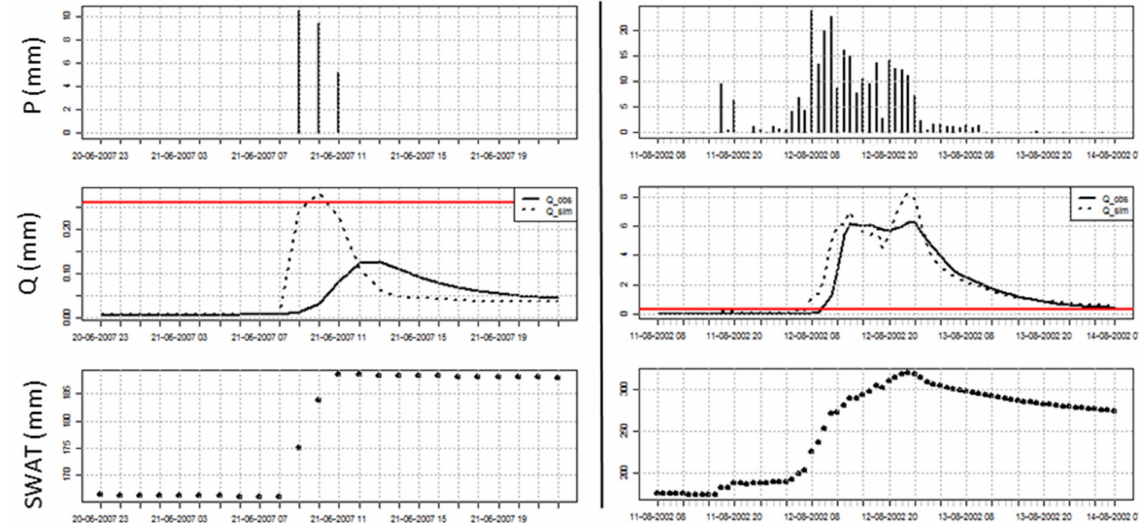
Figure 6. Examples of a false alarm (left side) and a correct alarm (right side). P = precipitation (mm), Qobs = observed discharge (mm), Qsim = simulated discharge (mm) and SWAT = estimated soil moisture (mm). The red line in the second row indicates the discharge